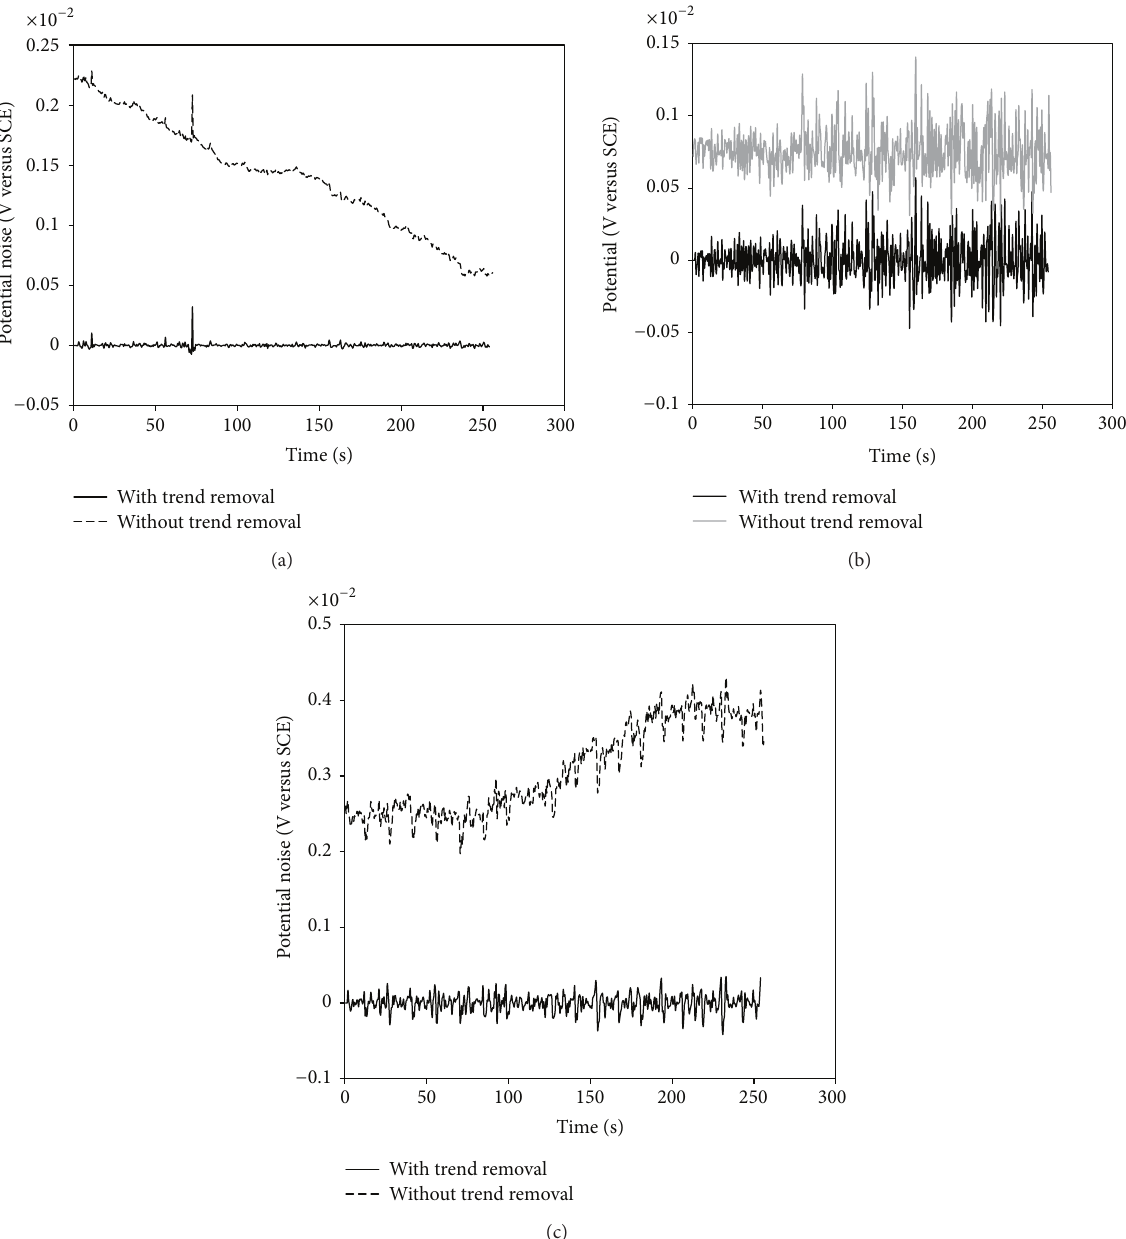
Figure 4: Electrochemical potential noise diagrams before and after trend removal for composite coatings obtained from plating bath containing different concentration of nano-Al 2 O 3 particles: (a) blank, (b) 5 ppm, and (c)